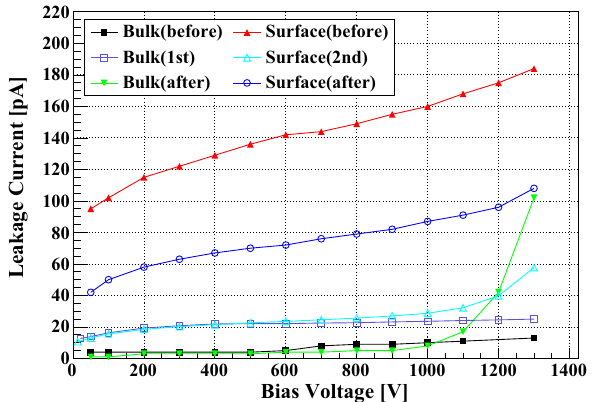
Fig. 14 LeakagecurrentsofdetectorUSD-R02versusitsbiasvoltages in LAr, except for the ones labeled “before” and “after”, which were measured in the USD vacuum cryostat at 90 K. The numbers denote the thermal cycles in LAr. Bulk leakage currents were measured through the central contact, surface ones were through the guard contact